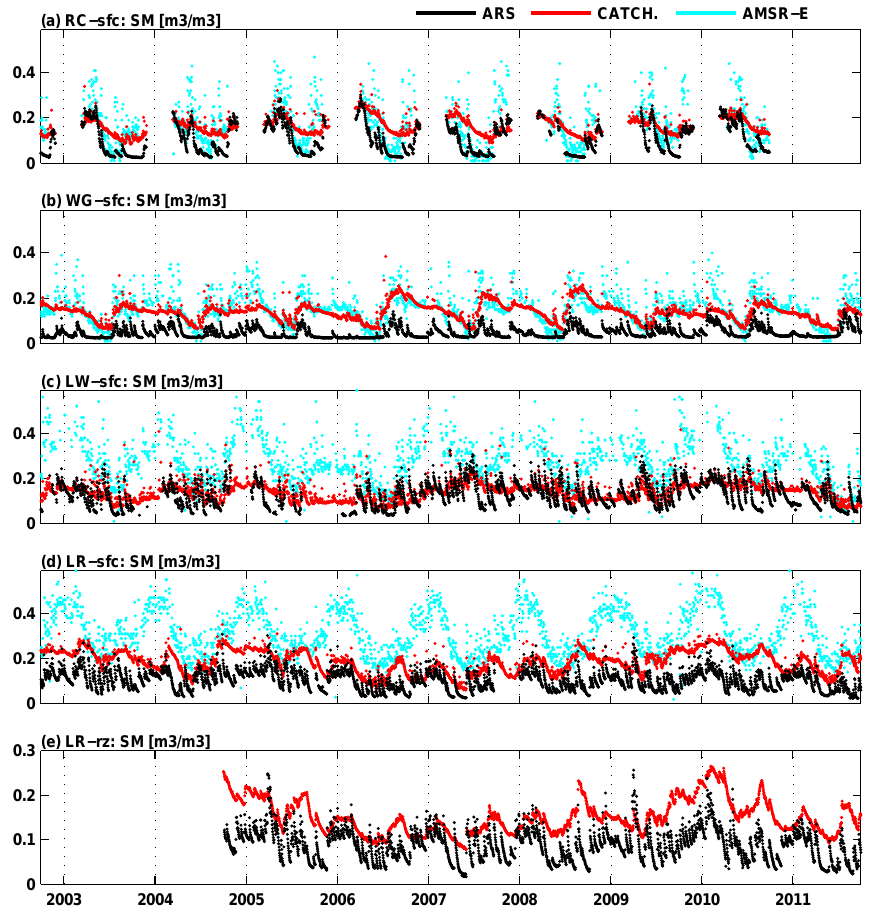
Figure 1. The ARS in situ, Catchment model, and AMSR-E remotely sensed surface soil moisture, with near-surface soil moisture at (a) Reynolds Creek, (b) Walnut Gulch, (c) Little Washita, (d) Little River, and (e) root-zone soil moisture at Little River.